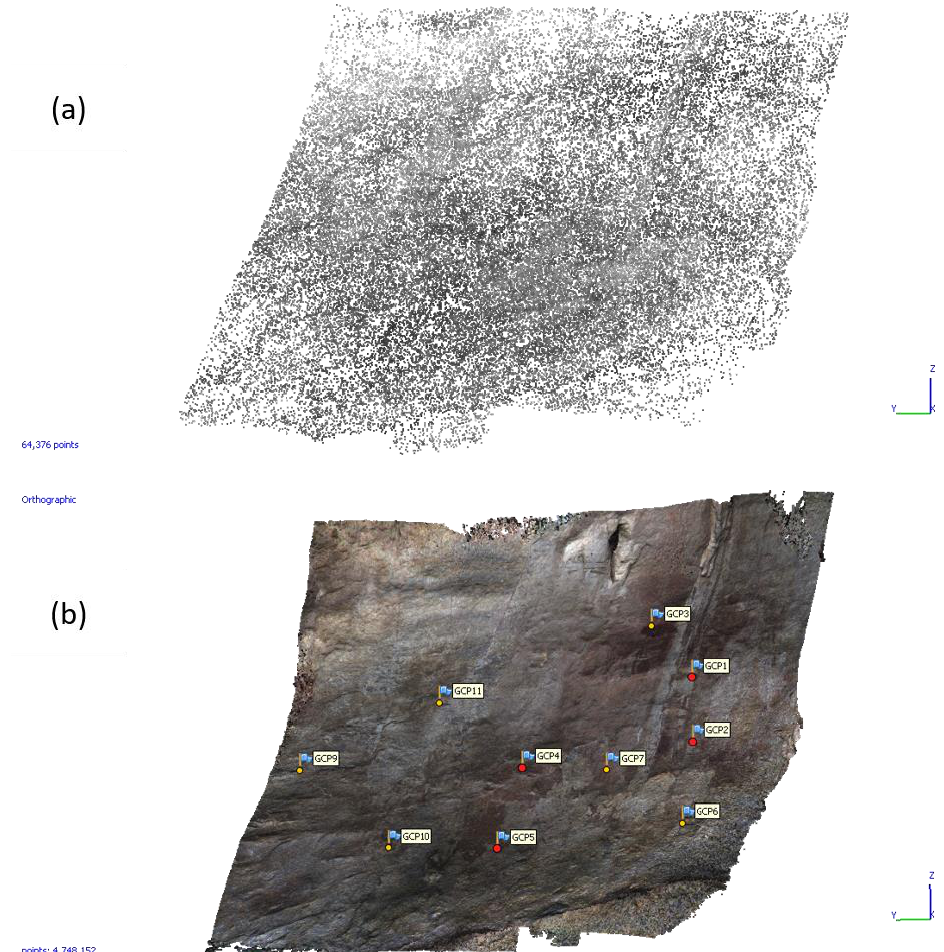
Figure 4: Point cloud reconstruction from SfM: (a) cleaned sparse point cloud, and (b) 3D dense point cloud of multispectral imagery based on default channel selection in PhotoScan with the distribution of control point (yellow point flag) and checkpoint (red point flag).